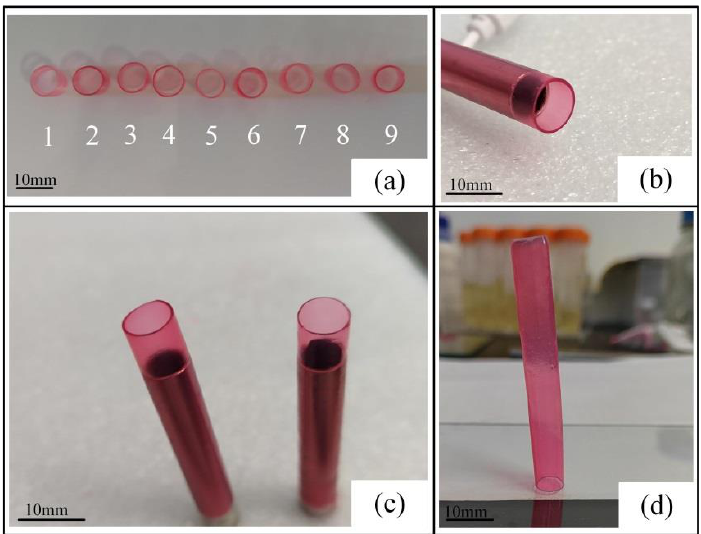
Figure 5. Vessel-like structure ( n = 9). ( a ) With the increase of the hydrogel contact angle, the blood vessel wall thickness gradually became thicker, and the color became darker. The order of vessel wall from thick to thin was 6, 9, 4, 2, 7, 3, 8, 5, and 1, which was consistent with the measured hydrogel contact angle change. ( b ) Side view of vessel structure; the printed vessel has a good molding effect, and the vessel wall is symmetrical, which can be easily pulled out of the spiral rod. ( c ) Comparison between vessel wall thickness of 0.48 mm (contact angle of 76°) and vessel wall thickness of 0.39 mm (contact angle of 73.36°). The difference between the thickness can be clearly seen from the vascular section, and the vascular wall becomes thinner with the decrease of the contact angle. The larger the difference in the hydrogel contact angle, the more obvious the difference in the vessel wall thickness. ( d ) The artificial blood vessel, which is placed vertically on the glass plate after leaving the screw rod, has good elastic mechanical support performance.